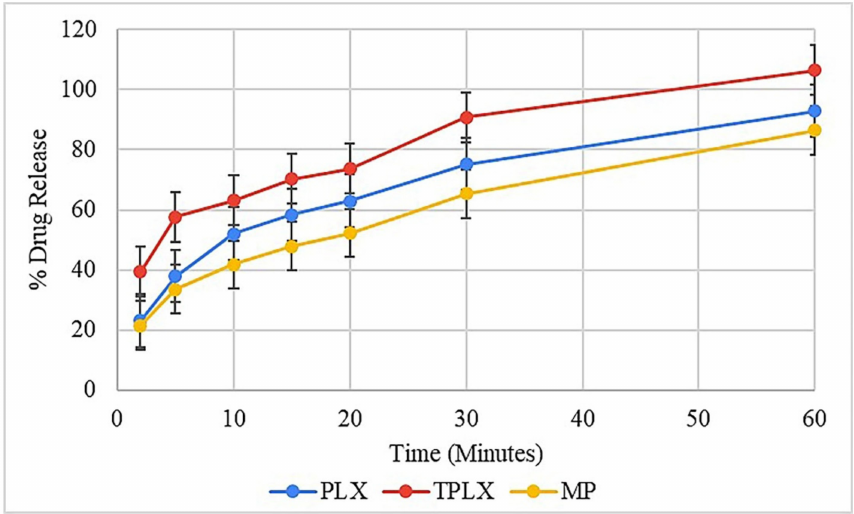
Figure 8. Describing the significant difference ( p < 0.05) in release of the drug from PLX- and TPLX-based